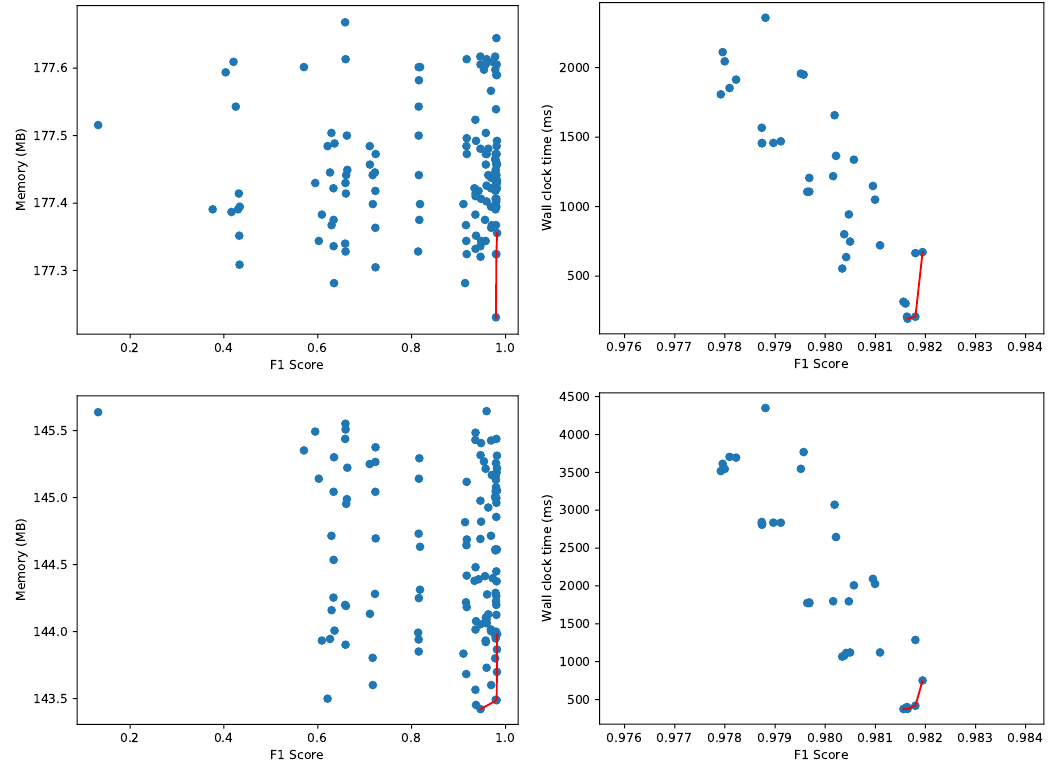
Figure 15. Pareto fronts for memory ( left ) and wall clock time ( right ) for the Enterprise anomaly dataset re-using One-Class SVM models on the Dell PowerEdge R620 server ( top ) and NVIDIA Jetson TX2 board ( bottom ).